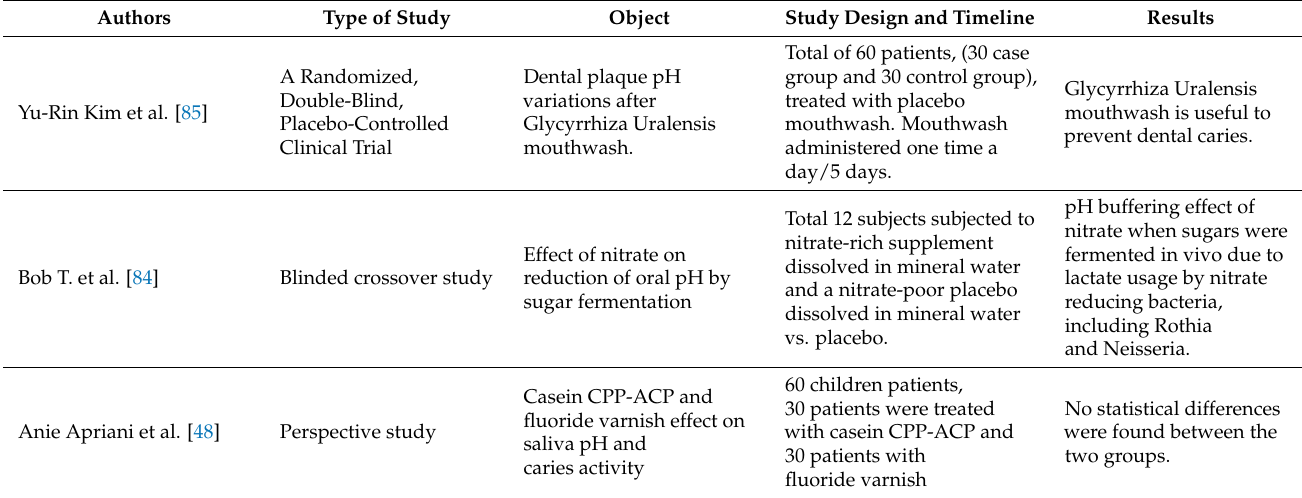
Table 3. Included studies that examined remineralization. [CPP-ACP: Casein